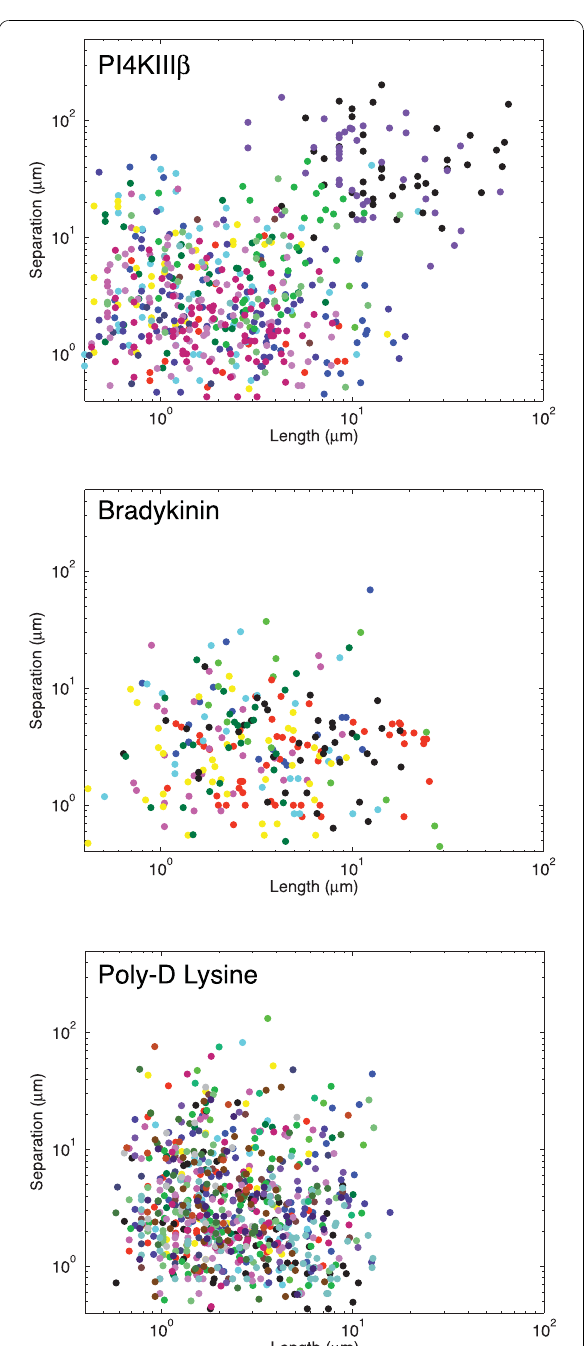
Figure 6 Filopodia length and distance separation are independent after perturbation . Graph of filopodial length and separation distance for PI4KIII b , Bradykinin and Poly-D-lysine perturbations. Identically coloured data points represent measurements from the same